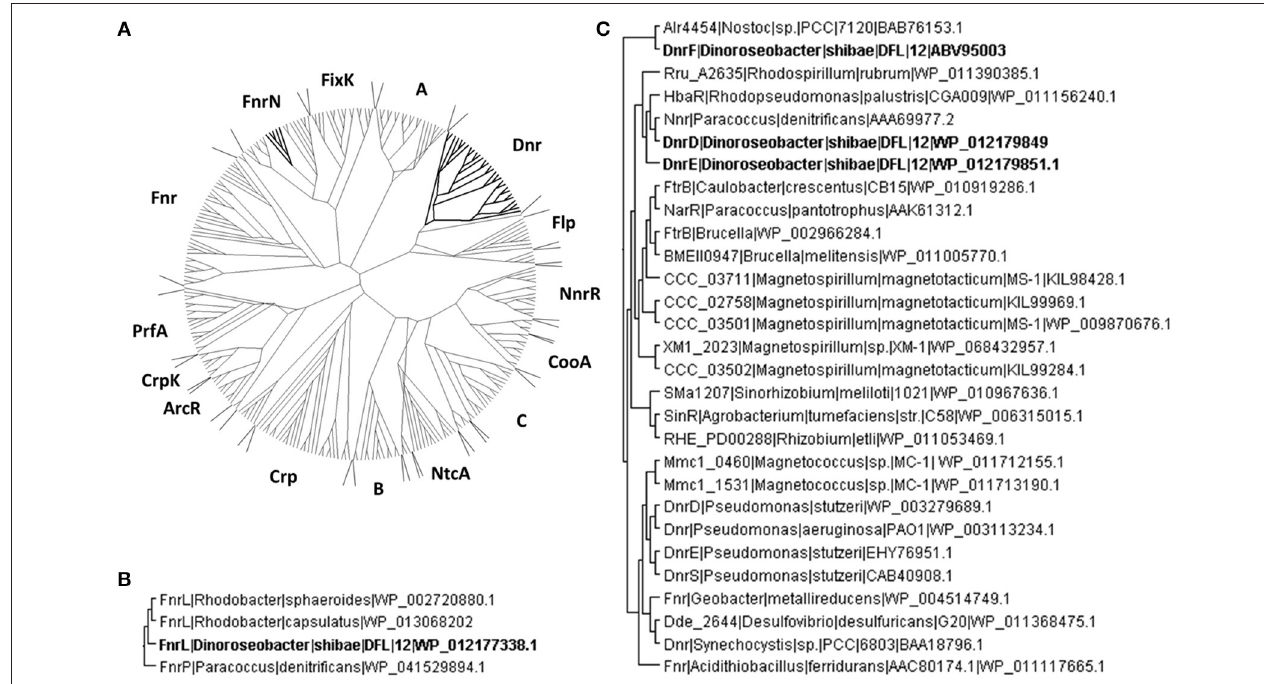
FIGURE 1 | Phylogenetic affiliations of the D. shibae Crp/Fnr-like regulators. (A) The unrooted neighbor joining trees containing D. shibae Crp/Fnr like regulators affiliated to the Crp/Fnr superfamily are shown. (B) FnrN subfamily of Fnr like regulators containing FnrL of D. shibae . (C) Dnr subgroup of Crp/Fnr like regulators containing three different Dnr regulators of D. shibae . The members of the tree are identified by the name of the host bacterium and the NCBI sequence identification number (accession